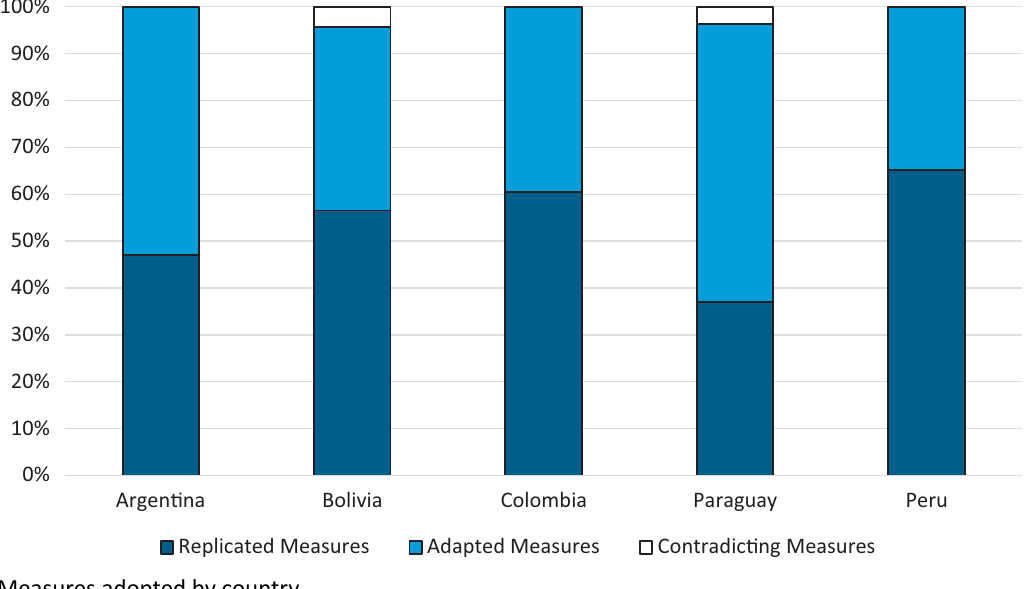
Figure 2. Measures adopted by